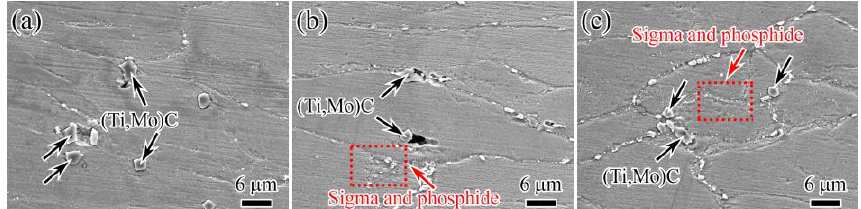
Figure 12. Microstructures of longitudinal section near tensile fracture surfaces of 15Cr–15Ni–Ti–xP alloy after stress rupture testing at 650 °C/195 MPa: ( a ) 15Cr–15Ni–Ti–70P alloy, ( b ) 15Cr–15Ni–Ti–150P alloy and ( c ) 15Cr–15Ni–Ti–250P alloy.